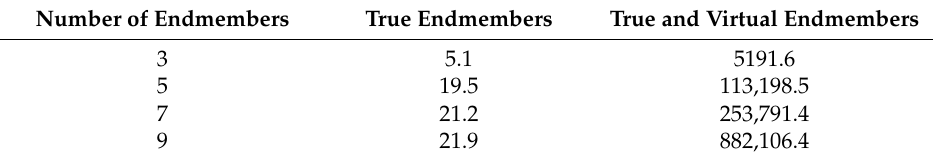
Figure 9. Endmember spectra. ( a ) Maple_Leaves DW92-1; ( b ) Olivine GDS70.a Fo89 165 um; ( c ) Calcite CO2004; ( d ) Quartz GDS74 Sand Ottawa; ( e ) Grass_dry.9+.1green AMX32; ( f ) Muscovite GDS107; ( g ) Alunite GDS82 Na82; ( h ) Uralite HS345.3B; ( i ) Mascagnite GDS65.a. Table 2. Comparison of minimum variance inflation factors (VIFs) under different numbers of